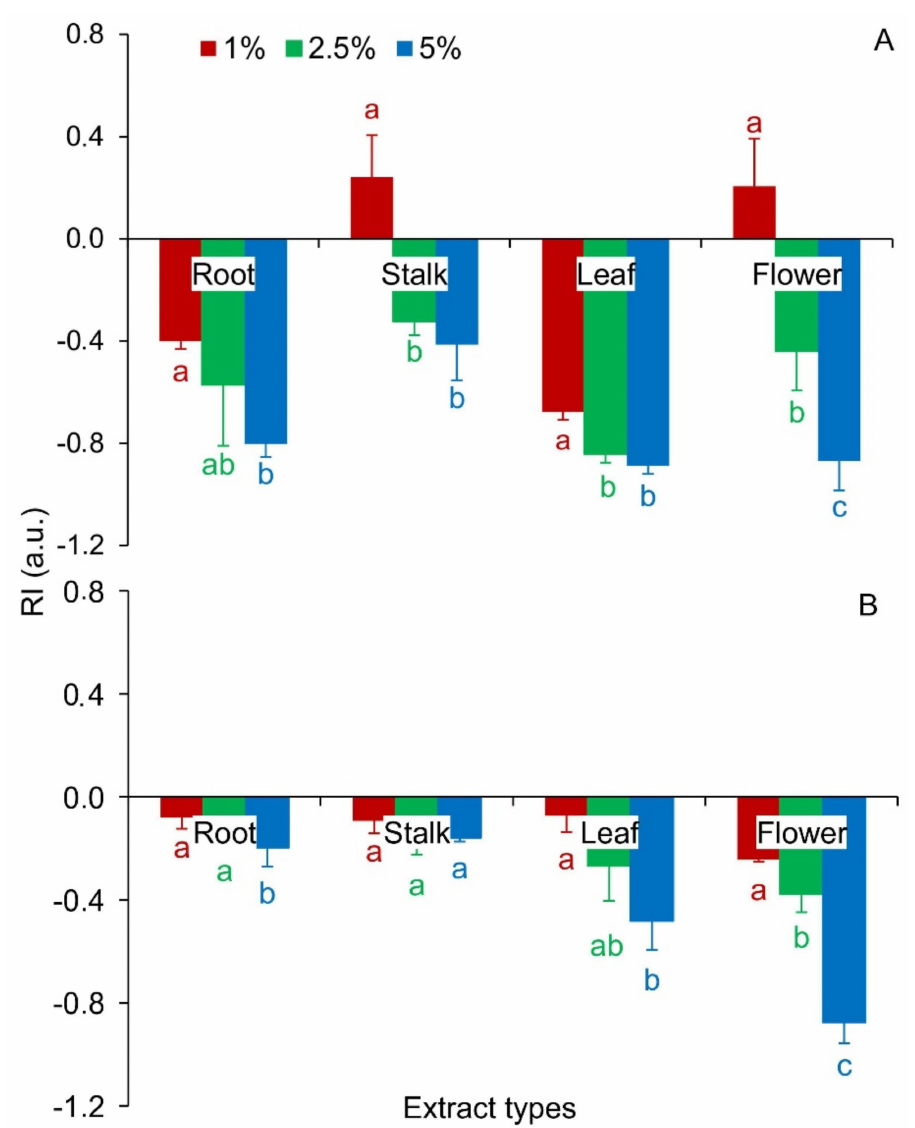
Figure 3. RI index—allelopathic seeds response for Festuca rubra L. ( A ) and Raphanus sativus L. var. radicula Pers. cv. Rowa ( B ) seeds treated with aqueous extracts from organs of Rosa blanda Aiton, with various concentrations (1%, 2.5%, 5%); the mean values of the three replicates ( n = 10, ± SD) marked with different letters are significantly different according to Duncan’s test p ≤